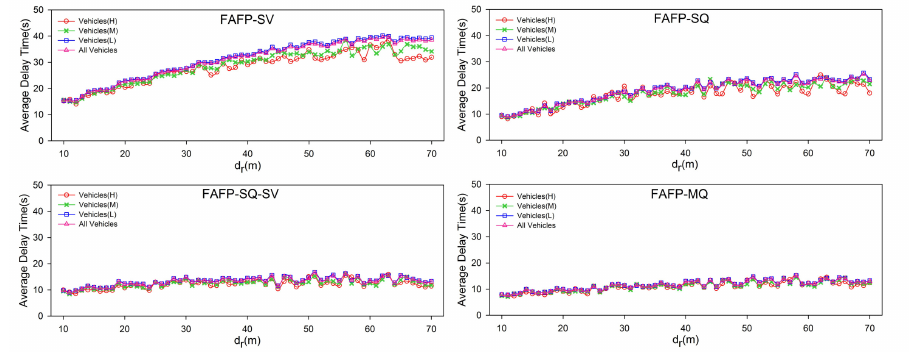
Figure 13. Average Delay Time of Vehicles{H,M,L} with the Change of d r of Four FAFP-based Policies: λ = 0.15, p υ . l = 4.5 m = 30%, p H = 5%, p M = 10%, p L = 85%, d a = 8 m, v m = 10 m/s, v r = 6 m/s, v γ = 8 m/s, N = 2.